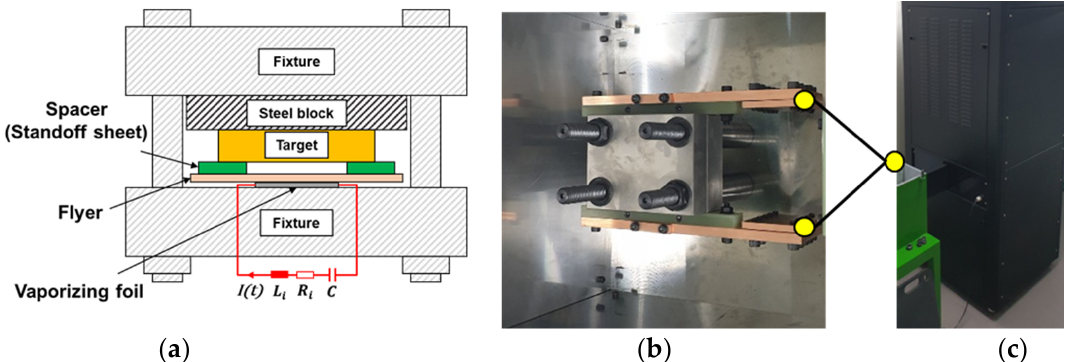
Figure 4. VFAW test equipment including die set and capacitor bank: ( a ) initial setting for VFAW experiments at the side view; ( b ) die set with copper plate at the top view; ( c ) capacitor